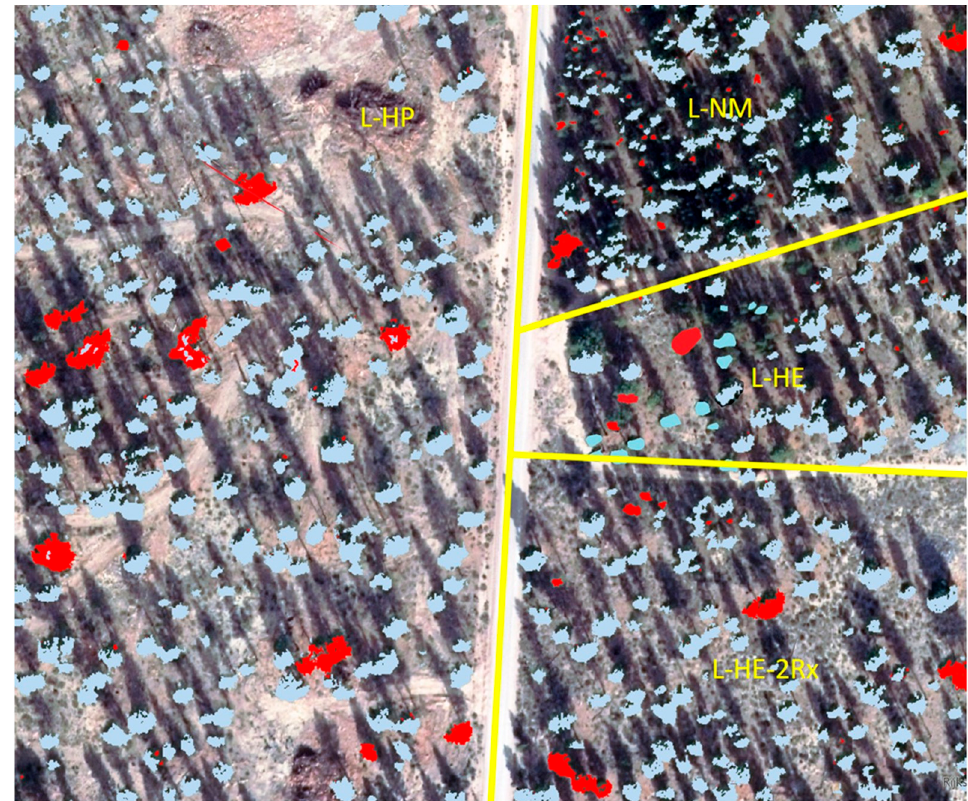
Figure 3. Aerial imagery collected in October 2017 (four (R, G, B, IR) bands, 30 cm resolution) with classified individual tree crowns (red = low vigor, blue = not low vigor). This image contains four different site treatments; on the upper right is L-NM, lower right L-HE-2Rx, left of the main road is L-HP, and between the two spur roads on the right is L-HE.